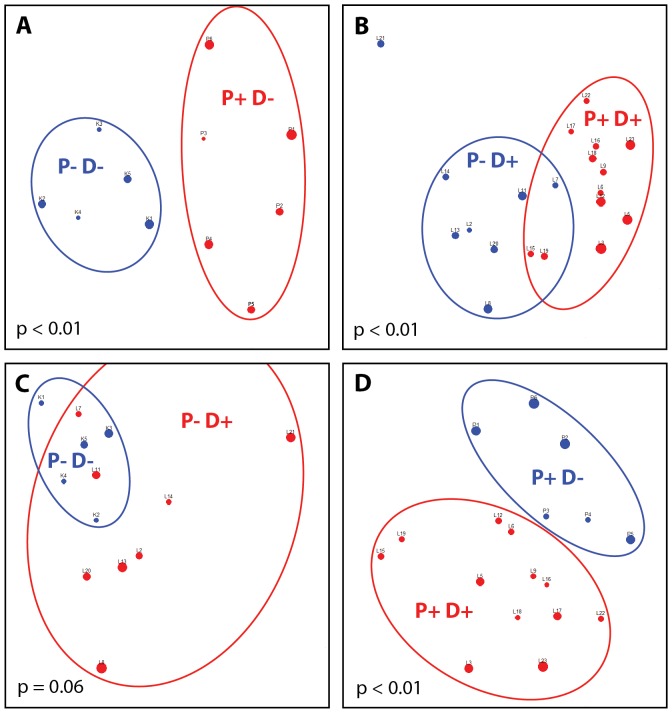
Subgingival plaque bacterial community composition comparison.The figure shows the results of non-metric multidimensional scaling (NMDS) applied to the unweighted UniFrac distances between different subsets of samples. The X- and Y-axes represent the first and second NMDS dimensions, respectively. The label next to each data point indicates the sample name. (A) Among diabetes-negative samples, a PERMANOVA test indicates significant (p<0.01) differences in the UniFrac distances according to the presence or absence of periodontitis. (B) A similar comparison among diabetes-positive samples is also significant (p<0.01). (C) Among periodontitis-negative samples, there is no clear separation based on diabetes status (p = 0.06). (D) In periodontitis-positive samples, however, significant differences do exist based on diabetes status (p<0.01).